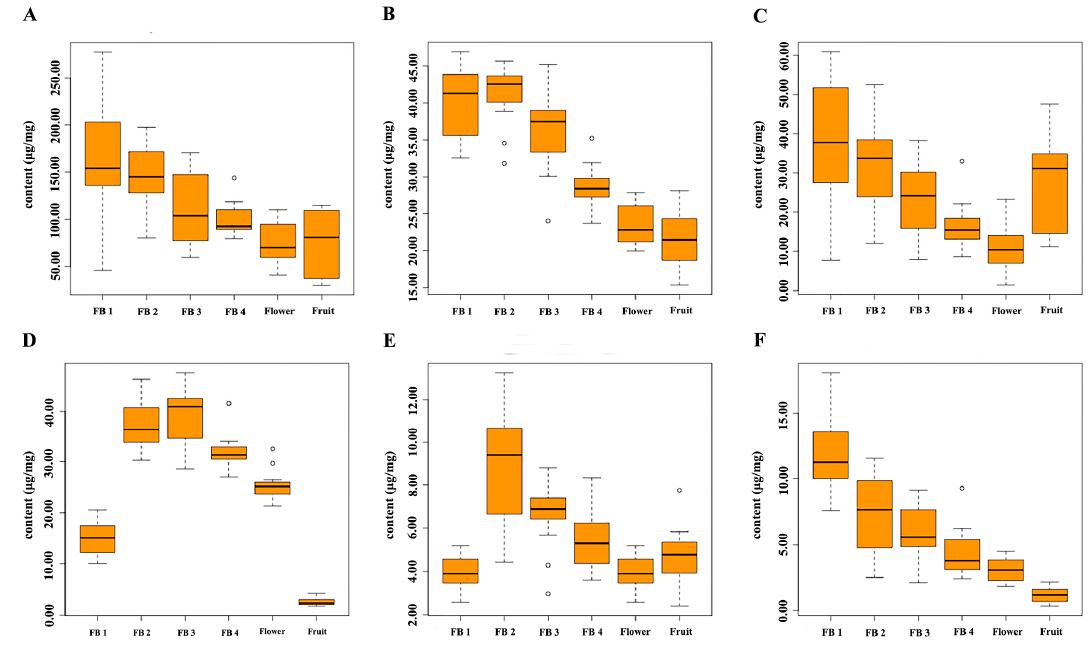
Figure 9. The accumulation patterns of main flavonoids in reproductive organs of S. baicalensis .